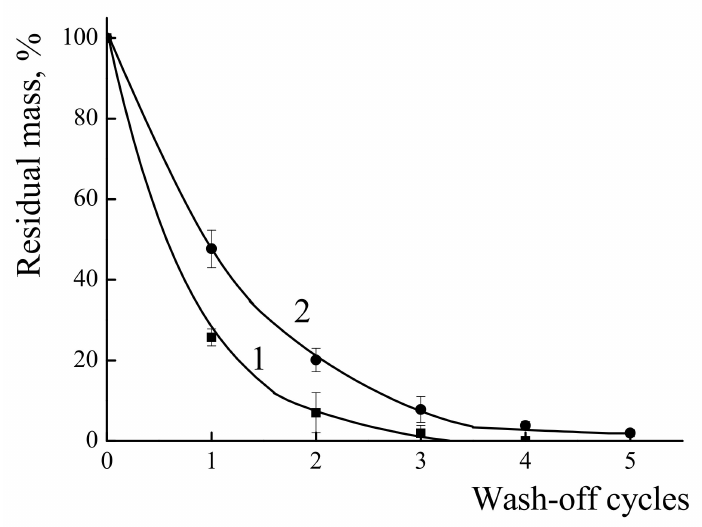
Figure 6. Dependence of the percentage of the retained mass of films formed from PDADMAC (1) and IPEC (2) on a glass surface on the number of wash-off cycles.